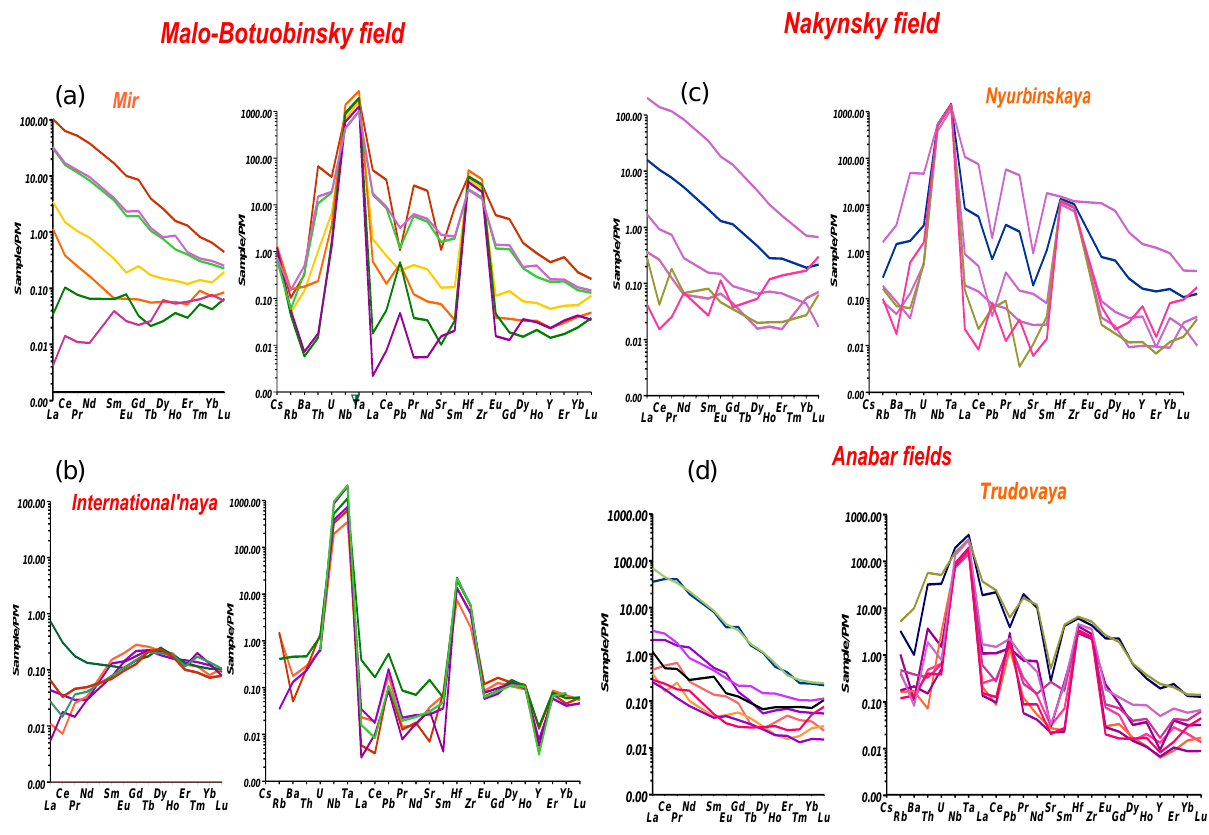
Figure 13. (a) REE patterns and trace element spider diagrams for ilmenites from heavy mineral separates from kimberlites from the Malo- Botuobinsky ( a Mir and b International’naya pipes), Nakynsky field ( c Nyurbinskaya pipe) and Anabar kimberlites ( d Trudovaya pipe). Fig.13 most enriched ilmenites show enrichment up to 1000/C1 for La have La / Yb n ∼ 15. They show no HfZr